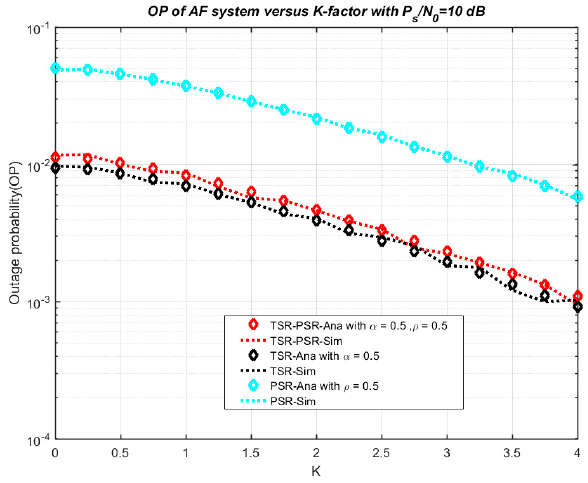
Figure 4. Outage probability versus K.